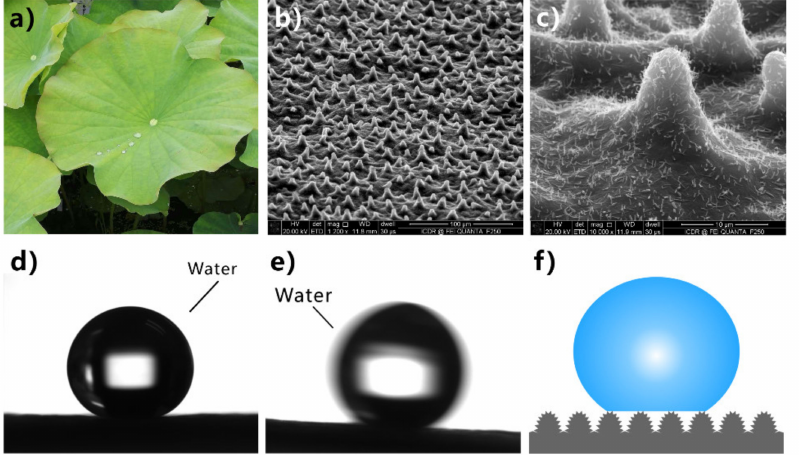
Figure 3. Superhydrophobicity of lotus leaves. ( a ) Lotus leaves. ( b , c ) Scanning electronic microscopy (SEM) images of the surface microstructure of the lotus leaf. ( d ) A drop of water on the lotus leaf. ( e ) Rolling of a water droplet on the surface of a lotus leaf. ( f ) Schematic diagram of the contact state between a water droplet and the superhydrophobic lotus leaf. Reprinted with permission from ref. [46]. Copyright 2017, American Chemical